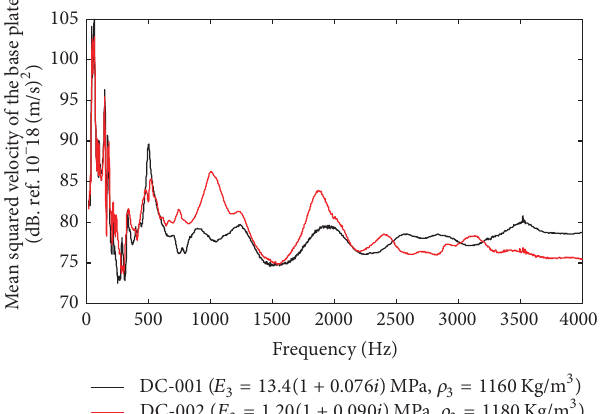
Figure 11: Mean squared velocities of the base plates of two specimens.